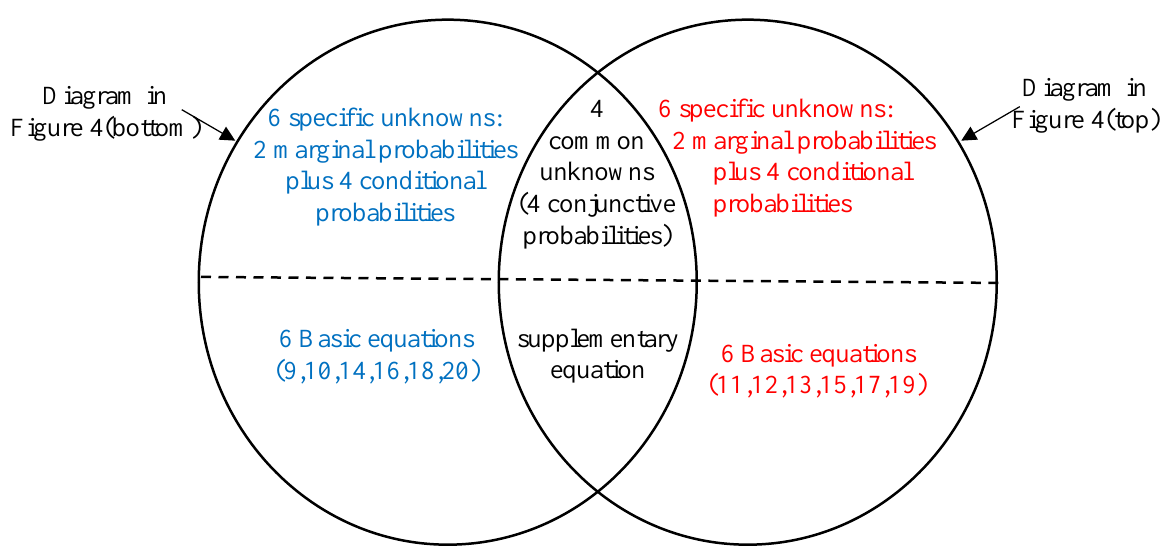
Figure 7. The splitting of unknowns and equations between the two diagrams in Figure 4